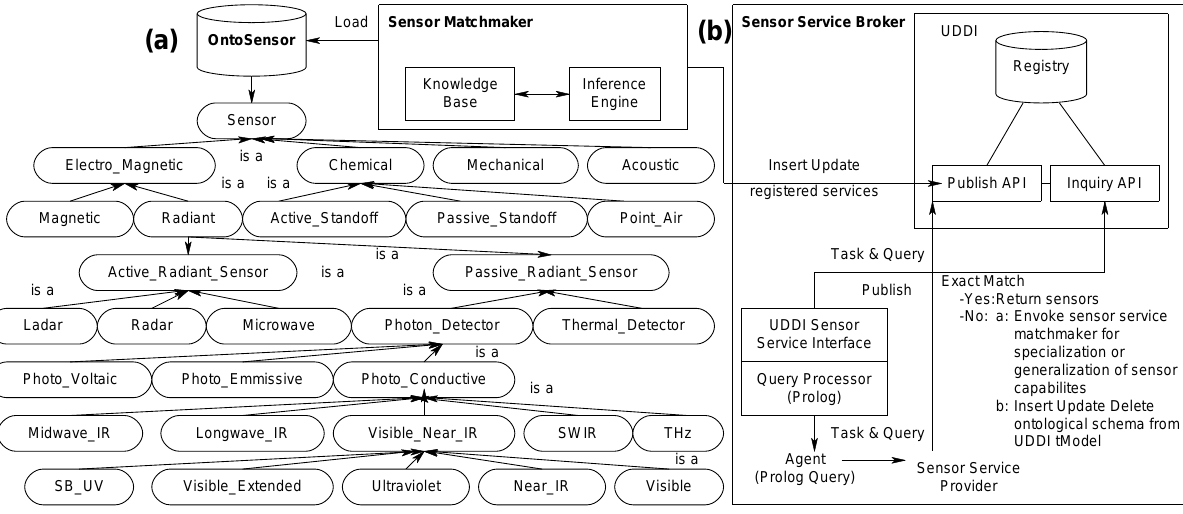
Figure 5. (a) Excerpt of the OntoSensor ontology. (b) Problem-solving for discovering and tasking sensor systems using